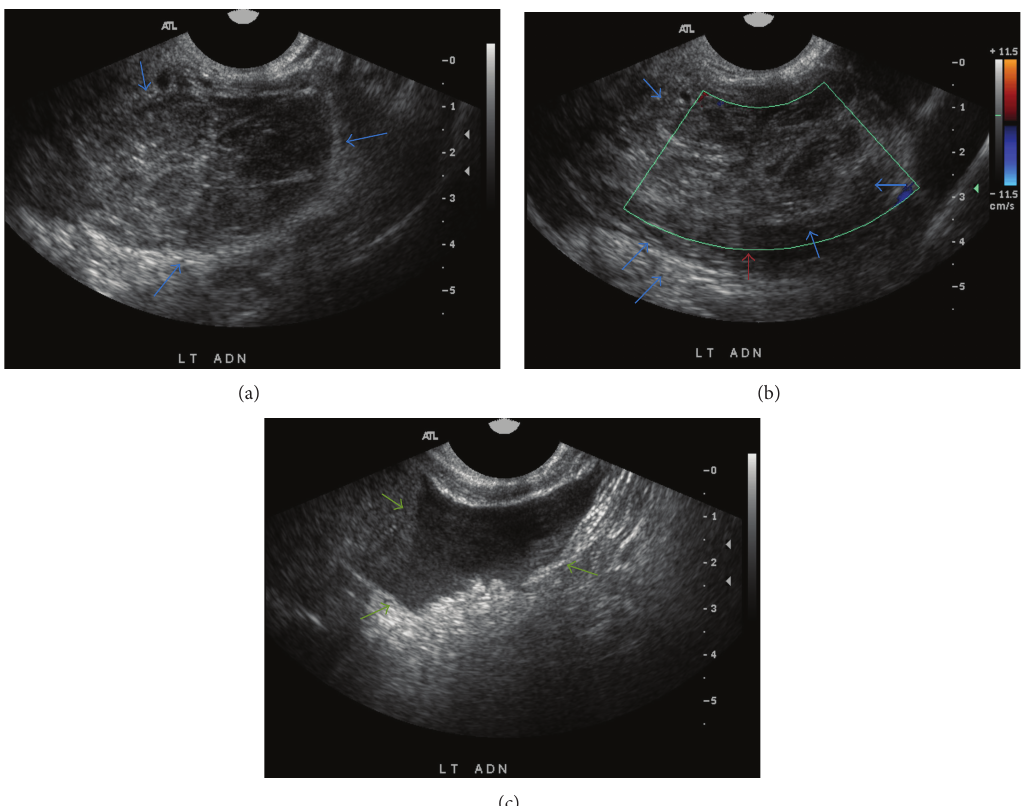
Figure 1: Sonographic images of the left adnexal region with and without color Doppler: large left adnexal mass (blue arrows), measuring approximately 6.3 × 3.9 cm, with heterogeneous echogenicity and no appreciable flow on color Doppler (red arrows). There is a moderate amount of free fluid (green arrows). Left ovary not definitively visualized [3].